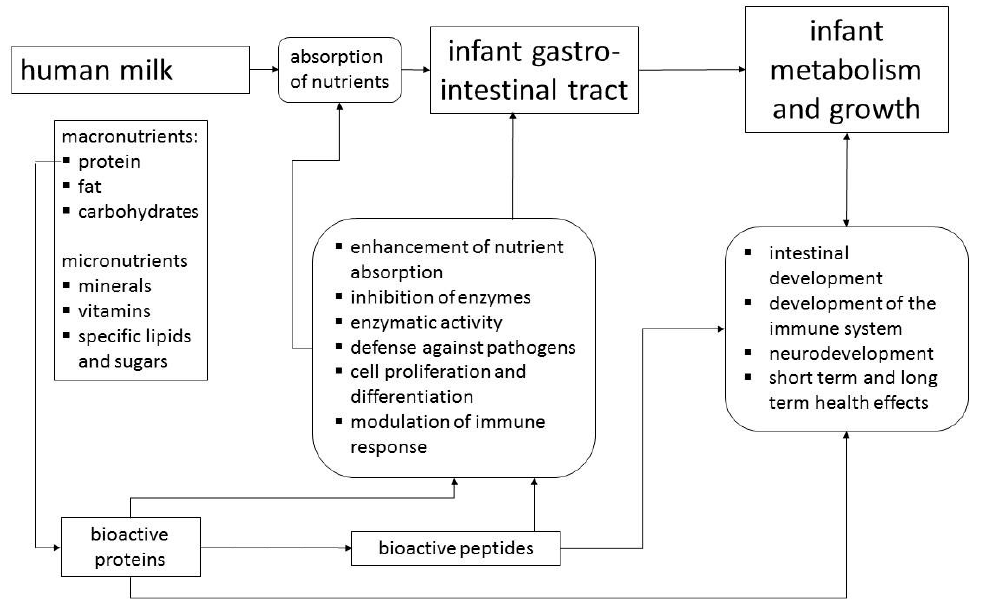
Figure 1. Human milk proteins support the development of the infant by their bioactivities and by providing amino acids as nutrients after digestion. Effects relate mainly to the digestive and developmental processes in the intestine, but can also be expected on whole organism